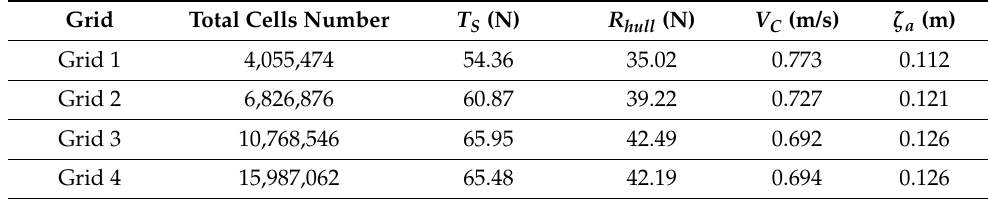
Figure 6. Program of self-propulsion simulation method for wave-driven catamaran. Table 2. Physical quantities under different